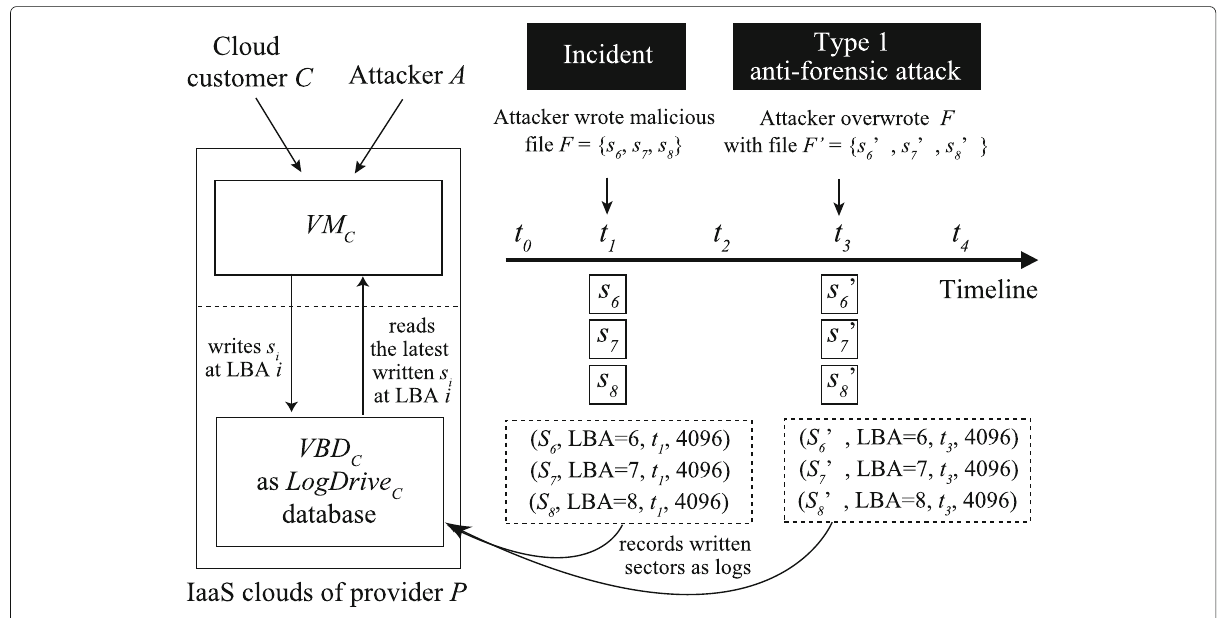
Fig. 3 System model of the collection function